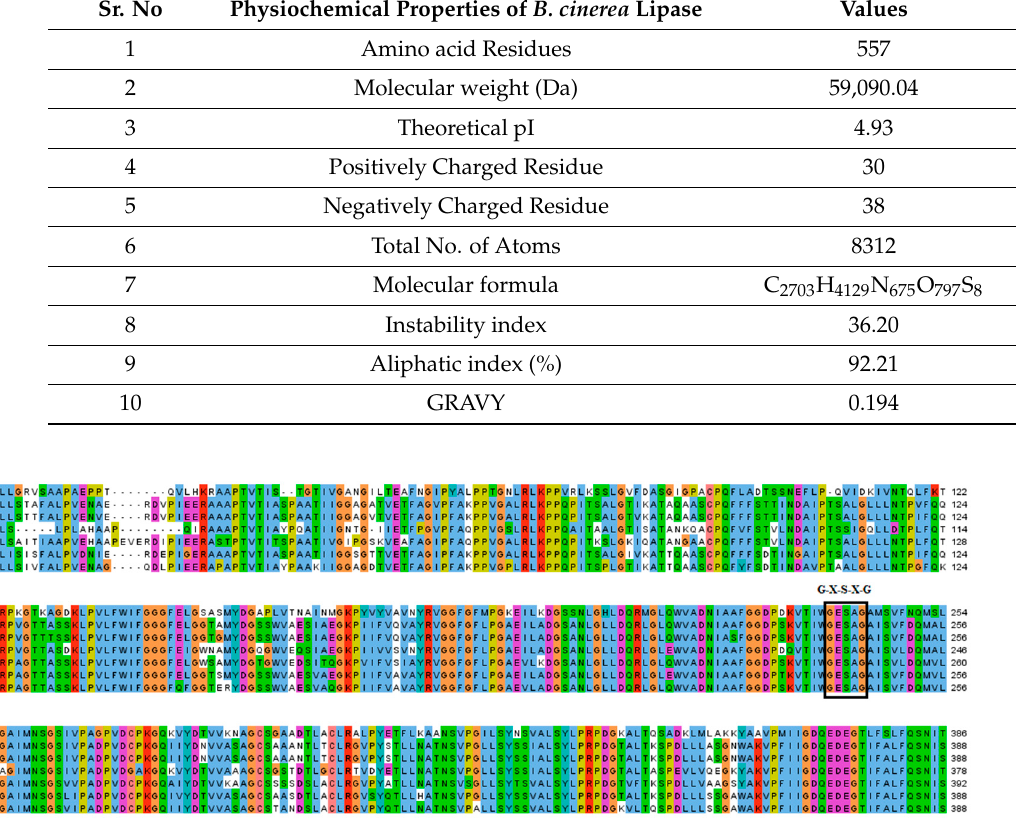
Table 1. Physicochemical properties of B. cinerea lipase. Physicochemical properties, including amino acid residues, molecular weight, theoretical pI, positively and negatively charged residues, molecular formula, instability index, aliphatic index (%), and GRAVY, are represented in the table. Sr. No